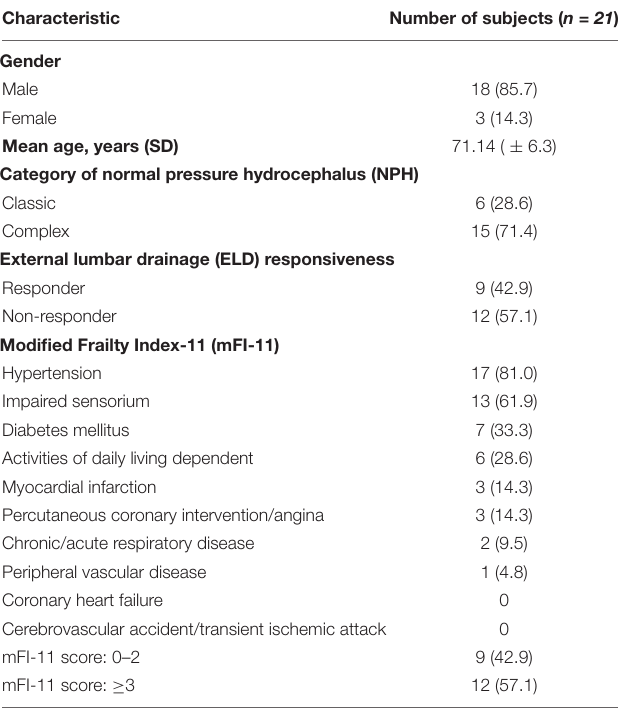
TABLE 1 | Clinical characteristics of normal pressure hydrocephalus (NPH)